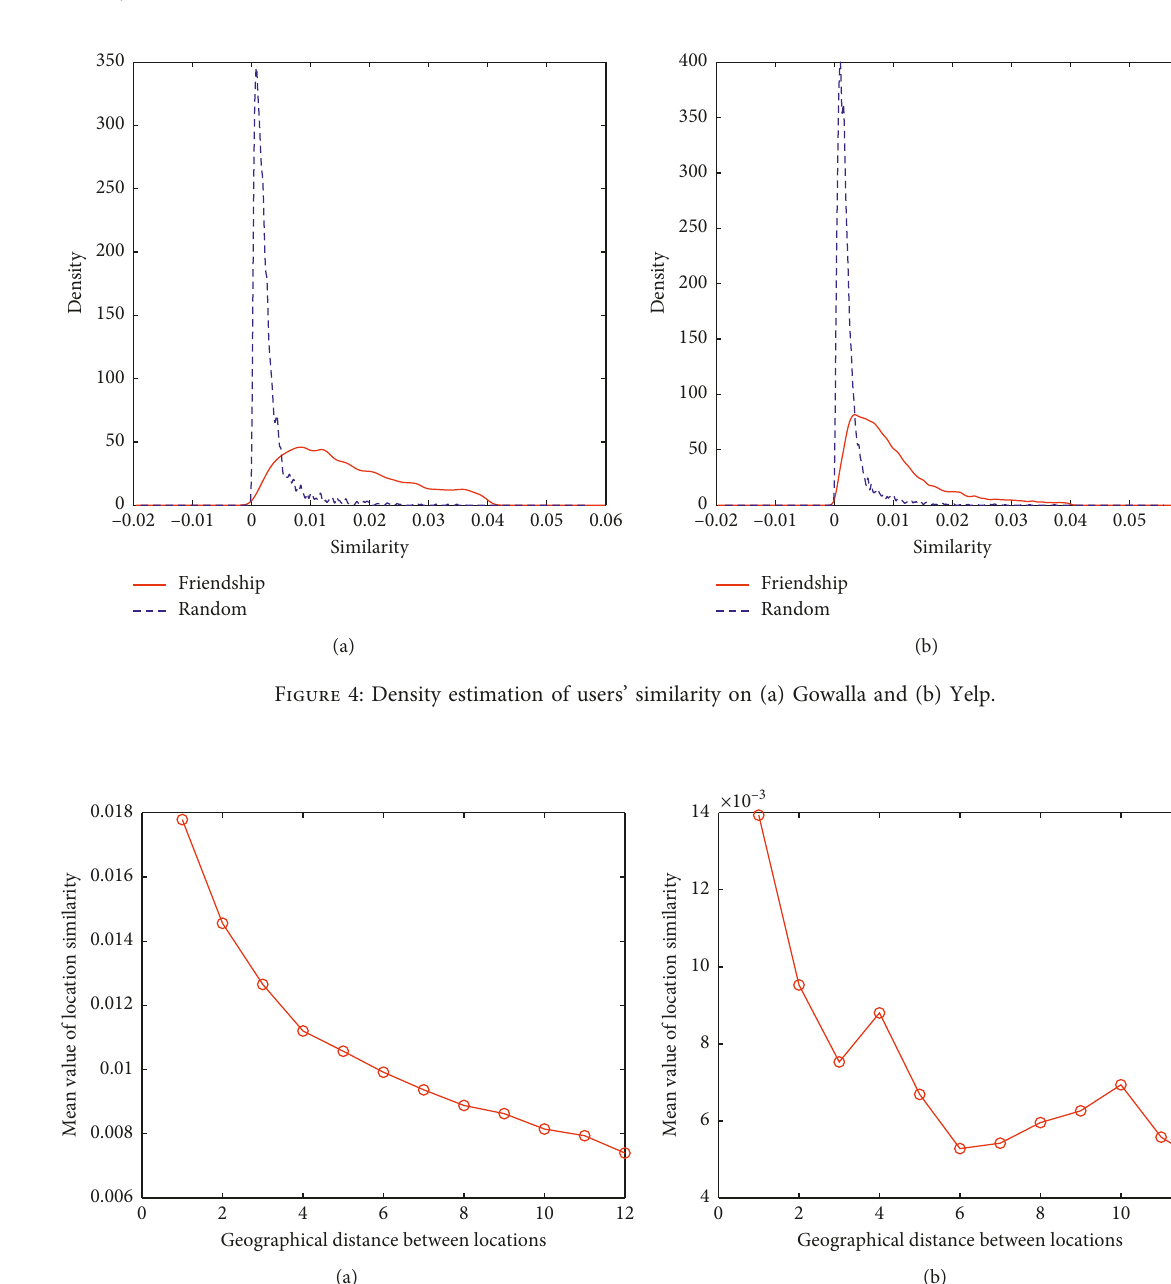
Figure 5: The similarity between POIs varies with geographical distance: (a) Yelp and (b) Gowalla.